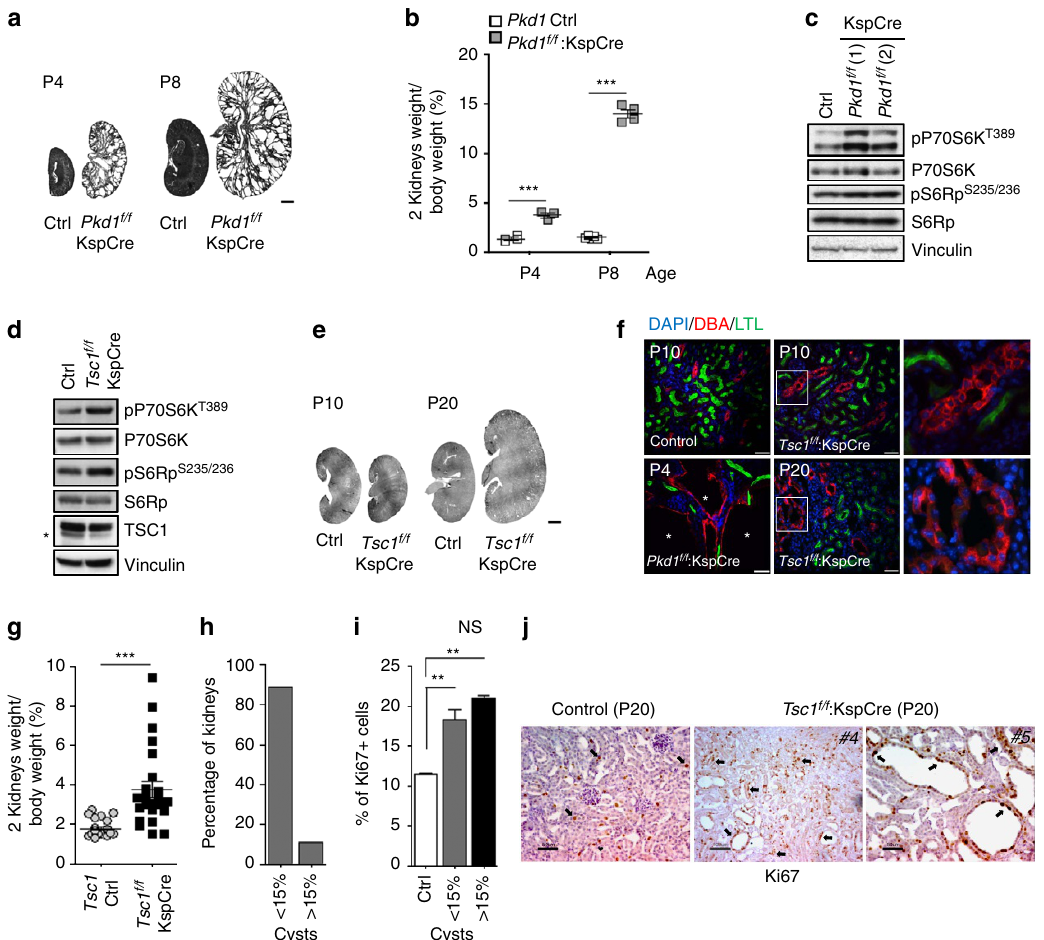
Figure 1 | Inactivation of Pkd1 and Tsc1 leads to a different phenotype. ( a ) H&E staining of kidney sections from controls mice and Pkd1 f/f :KspCre at P4 and P8. Scale bar, 1,000 m m. ( b ) Graph shows the two kidneys weight over body weight ratio for controls and Pkd1 f/f : KspCre mice analysed at P4 (controls n ¼ 4, cystic n ¼ 3) and P8 (controls n ¼ 5, cystic n ¼ 4). Data are shown as mean ± s.e.m. ANOVA statistical analysis (*** P o 0.0001) followed by Bonferroni’s multiple comparison test was performed. *** P o 0.001. ( c ) Representative western blot analysis of total kidney lysates from Pkd1 f/f :KspCre mice compared to control shows upregulation of the mTORC1 cascade at P4. ( d ) Western blot analysis of total lysates from P10 Tsc1 f/f :KspCre and control kidneys. Data are reperesentative of four independent experiments. ( e ) Representative H&E staining of kidney sections from Tsc1 f/f :KspCre mice and controls at P10 and P20. Scale bar, 1,000 m m. ( f ) Immunofluorescence on kidney sections from Pkd1 and Tsc1 mutants performed with markers of the proximal (LTL, green) and distal tubules/collecting ducts (DBA, red). Scale bar, 45 m m. ( g ) Graph shows the two kidneys weight over body weight ratio in Tsc1 f/f :KspCre mice ( n ¼ 25) versus controls ( n ¼ 26). Data are shown as mean ± s.e.m. Student’s unpaired two-tailed t -test was performed. *** P o 0.001. F test was performed to compare variances. ( h ) Graph shows the distribution of P20 Tsc1 f/f :KspCre ( n ¼ 9) mice according to the percentage of cysts affecting the kidneys. ( i ) Graph shows the percentage of Ki67 positive cells in controls ( n ¼ 3) and in Tsc1 f/f :KspCre mice (cysts o 15% n ¼ 6, cysts 4 15% n ¼ 3) performed at P20. A minimum of 5,000 cells per sample was counted (1,500 cells per section in three different sections in each sample). Data are shown as mean ± s.e.m. ANOVA (*** P ¼ 0.0007) followed by Dunnett’s multiple comparison test was performed. ** P o 0.01, *** P o 0.001. ( j ) Figure shows immunohistochemistry for Ki67 proliferation marker performed on kidney sections from control and Tsc1 f/f : KspCre mice at P20. Arrows evidence Ki67 positive nuclei. Scale bar, 50 and 100 m m. ANOVA, analysis of